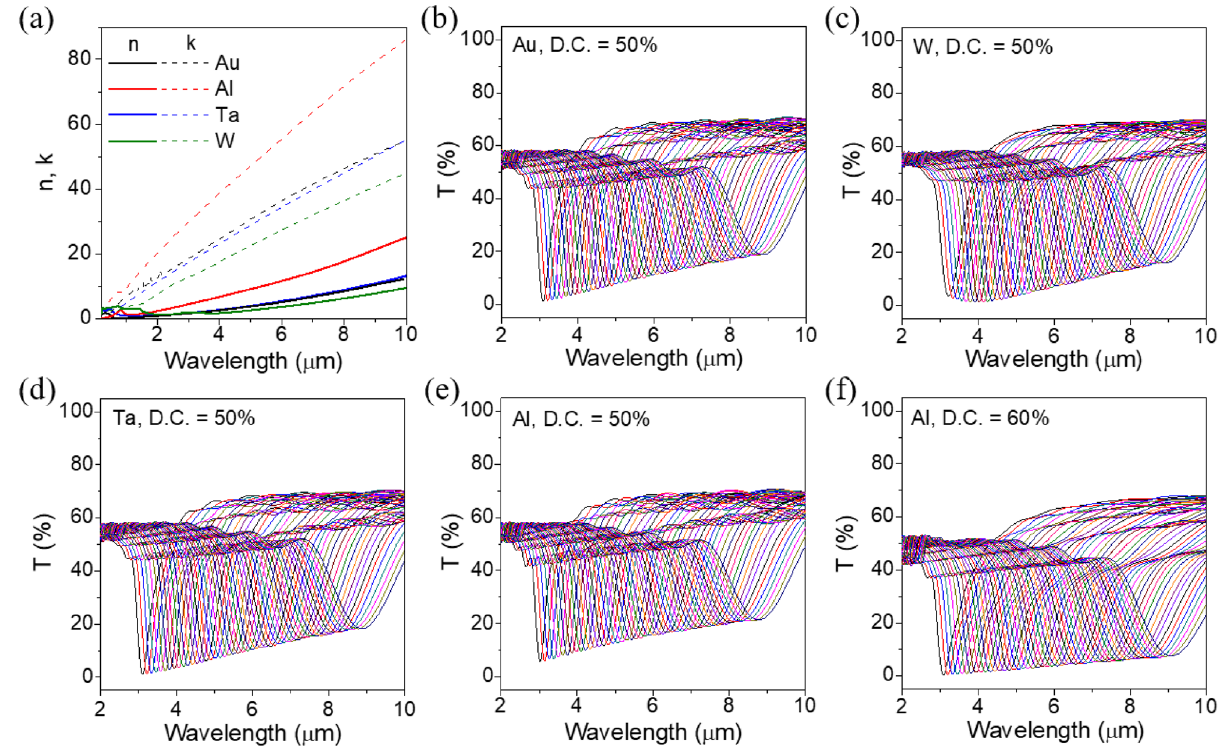
Figure 2. ( a ) Optical constants of various metals in the mid-infrared region and the simulated transmittance spectra for ( b ) Au, ( c ) W, ( d ) Ta, ( e ) Al nanodiscs array with a duty cycle of 50%, and ( f ) Al nanodiscs array with a duty cycle of 60%.